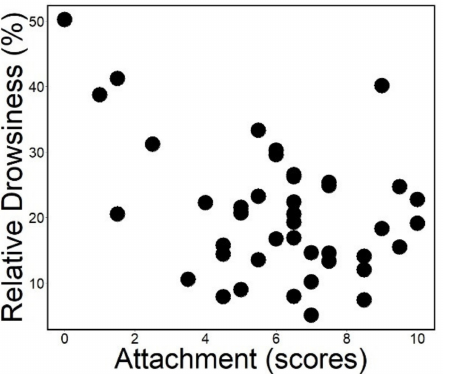
Figure 3. Relative duration of drowsiness plotted as a function of attachment scores measured in the Strange Situation Test. (The association is not significant after controlling for age).